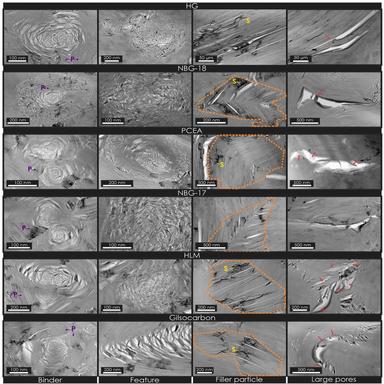
TEM micrographs of the phases and features of medium-coarse to medium-fine nuclear graphite grades. P – platelets, S – crystal strains. Red arrows indicate the presence of material inside the pores. (For interpretation of the references to colour in this figure legend, the reader is referred to the web version of this article.)